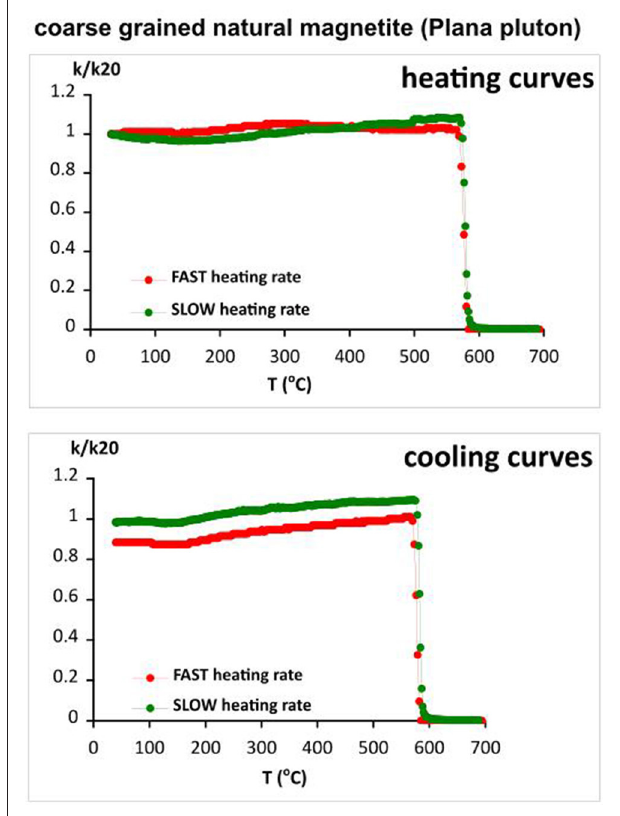
FIGURE 11 | Heating and cooling curves of the thermomagnetic analysis carried out with slow and fast heating rates for natural coarse grained